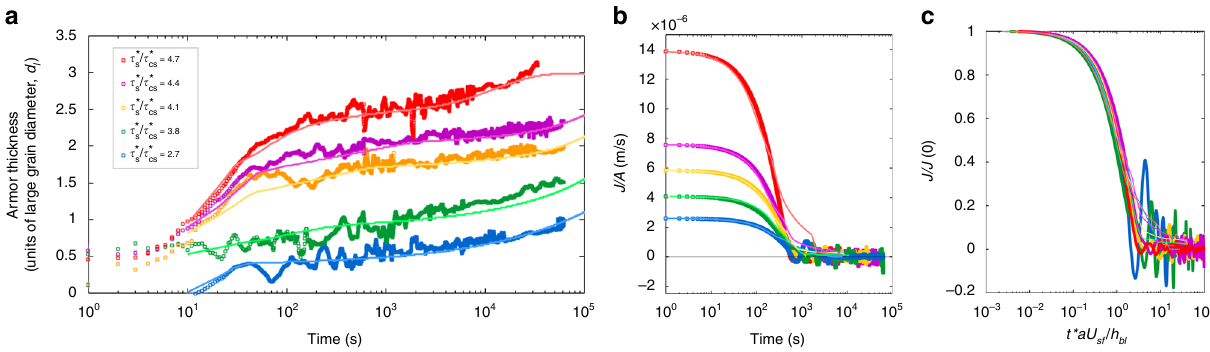
Fig. 4 Armour thickness and segregation fl ux through time. a Temporal evolution of the thickness of the armored layer at different Shields number. Legend indicates Shields number associated with each curve, and applies to b , c also. The brighter continuous lines are predictions from the advection-diffusion model, Eq. (2). Note the fi rst rapid stage of armouring, which is dependent on Shields number and is associated with bed-load transport, and the second slower stage that exhibits a nearly constant rate for all Shields numbers and is the result of creep. b The variation of segregation fl ux density ( J / A ) with time. c Normalized fl ux against dimensionless time; data are implement the simplest choice: a quadratic function F ( ϕ l ) = ϕ l (1 ϕ = 0.5, which assumes that small − ϕ l ) that is symmetric about l and large grains behave identically but in opposite directions. The